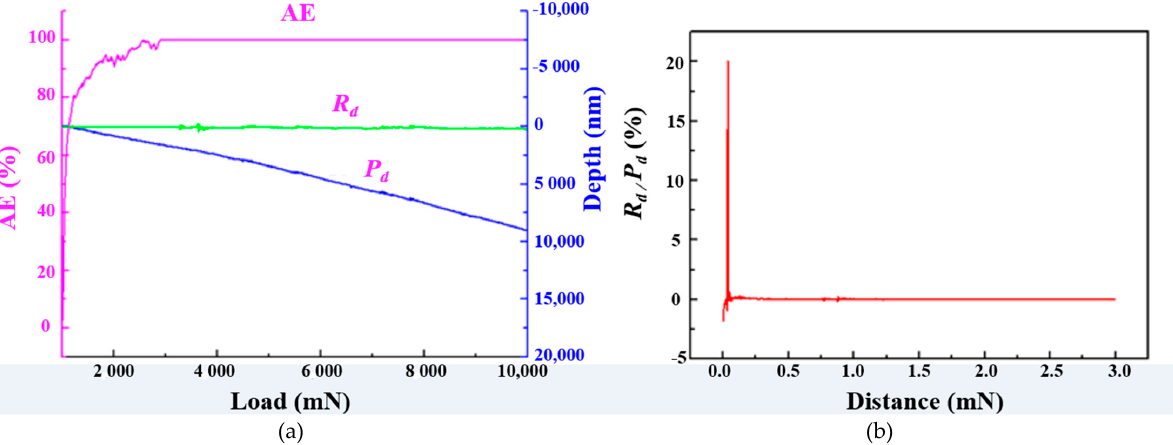
Figure 8. Results of scratching experiment (1–10 N loading): ( a ) main load–displacement curves; ( b ) elastic deformation shape.